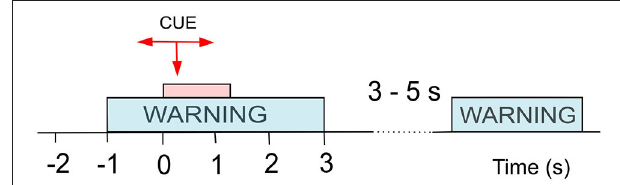
FIGURE 1 | Experimental setup for cue-based motor imagery (MI) tasks as used in both Dataset 1 (Vuckovic et al., 2014) and Dataset 2 (Vuckovic et al., 2018b). At t = − 1 s a warning signal (a cross) appeared on a computer screen, followed by a cue (an arrow) at t = 0 s. The cue stayed on the screen until t = 1.25 s while the warning stayed until t = 3 s. A volunteer was asked to perform repetitive imagination of movement from t = 0 s until the warning disappeared at t = 3 s. Different arrows indicated motor imagery of different